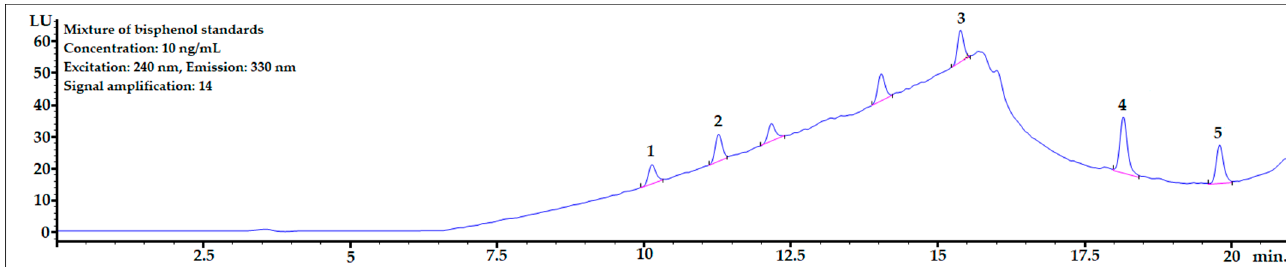
Figure 3. The chromatogram of the mixture of bisphenol standards at 10 ng/mL dissolved in MeOH. 1 — BPF, 2 — BPE, 3 — BPAF, 4 — BADGE ∙ 2HCl, 5 — BPP .